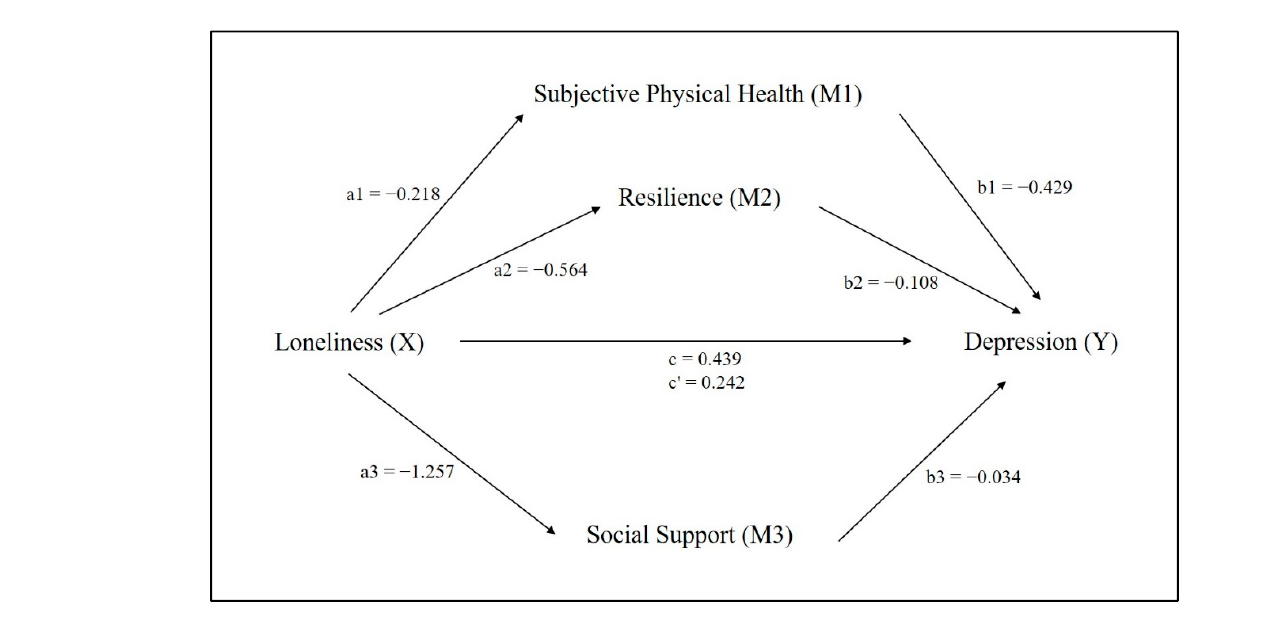
Figure 3. Parallel mediation model for loneliness and depression via subjective physical health, resilience, and social support.